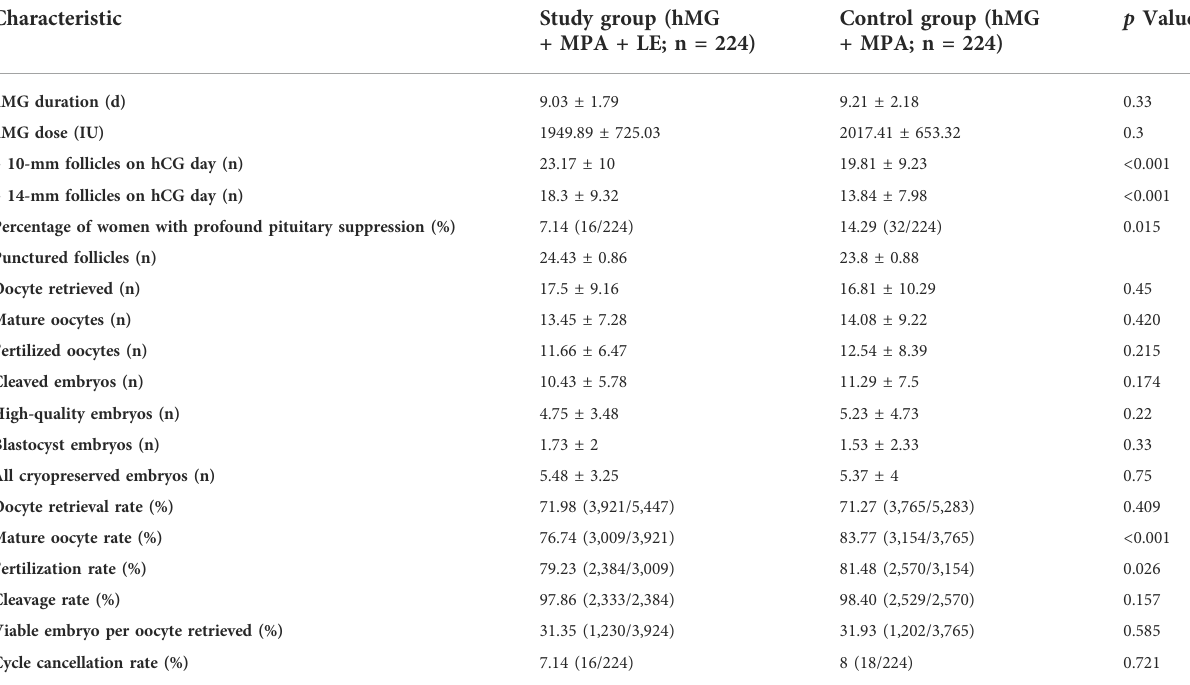
TABLE 2 Cycle characteristics of COS in the two